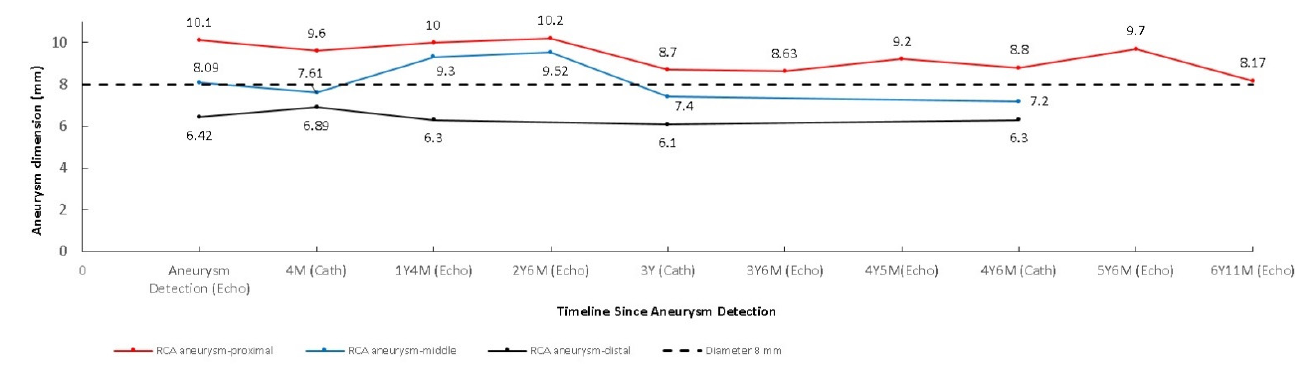
Figure 3. Aneurysm diameter through all clinical course was showed in this figure.The timeline from initial aneurysm detection to long-term follow-up (6 years 11 months). The dashed line indi- cates a giant aneurysm border (8 mm). Two aneurysms near or exceeding 8 mm in size (red and- blue line) and one medium-sized aneurysm (black line). All three aneurysms showed no significant regression whether from echocardiography or invasive angiography